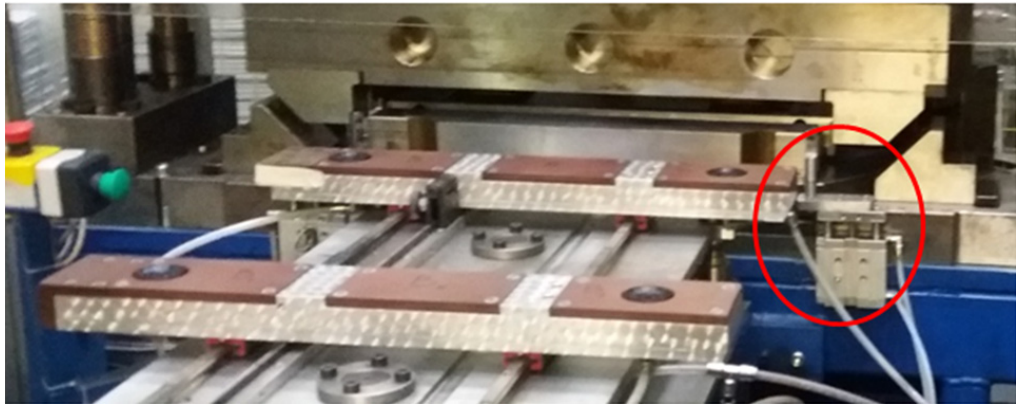
Figure 16. The stop position of the engine.